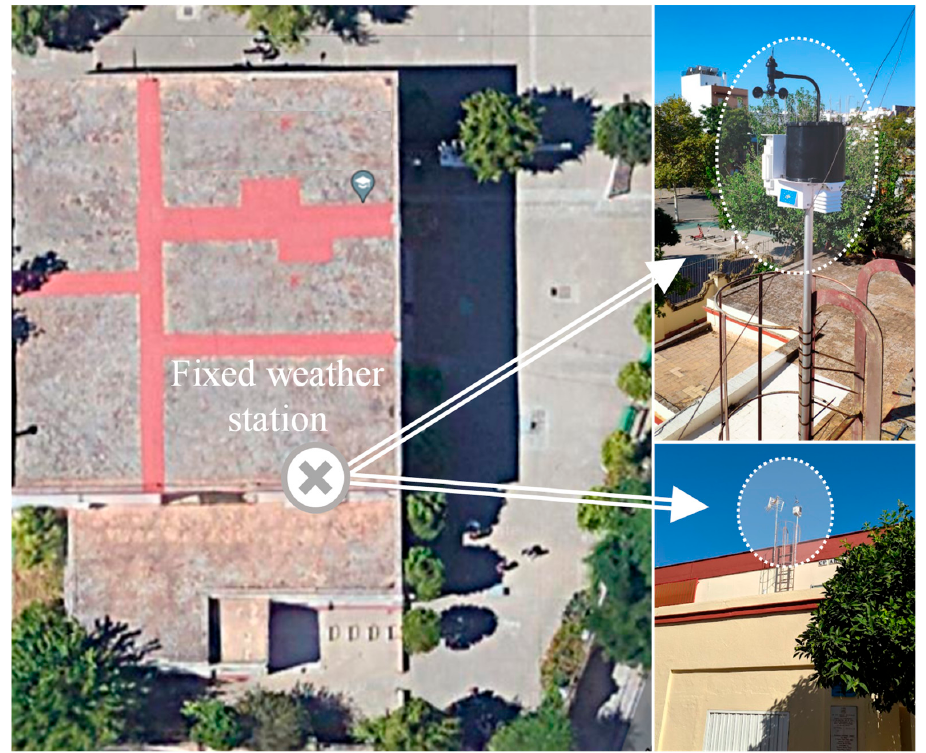
Figure 3. School fixed weather station.